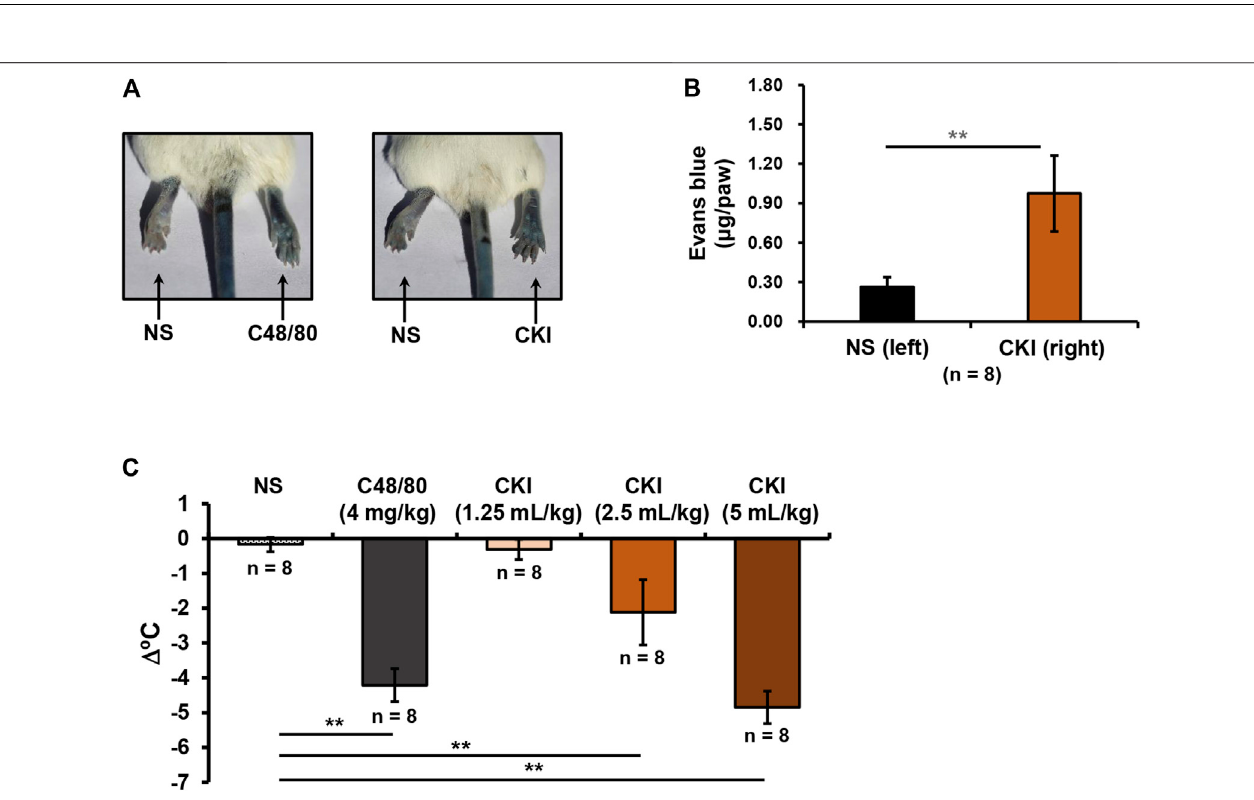
FIGURE 3 | CKI can induce NIN-IHRs. (A) Representative images of Evans blue extravasation. Mice were injected (i.v.) with Evans blue (0.65 μ mol). Five minutes later, right paw of mice was intraplantarly injected with CKI (10 μ l/paw), and the left paw was injected with 10 μ l of NS. C48/80 (0.3 μ g/paw) was used as a positive control. Thirty minutes later, the mice were euthanized and photographed. (B) Quanti fi cation of Evans blue leakage into the paw. Paw tissues were collected and Evans blue in the paw tissues was extracted by DMF at 50 ° C overnight ( > 20 h). OD values were read at 620 nm. The concentration of the dye in the paw tissue was calculated according to the standard curve of Evans blue. ** p < 0.01. (C) CKI induced hypothermia in propranolol-pretreated mice. The mice were pretreated (i.v.) with propranolol (0.118 μ mol/mouse) 20 min before CKI (1.25 – 5 ml/kg) challenge (i.p.). C48/80 (4 mg/kg) was used as a positive control. The mice in the negative control group were received equivoluminal NS. Thirty minutes later, the rectal temperature was measured. ** p < 0.01. C48/80, compound 48/80; CKI, Compound Kushen Injection; NIN-IHRs, non-immunologic immediate hypersensitivity reactions; NS, normal saline; OD, optical density.